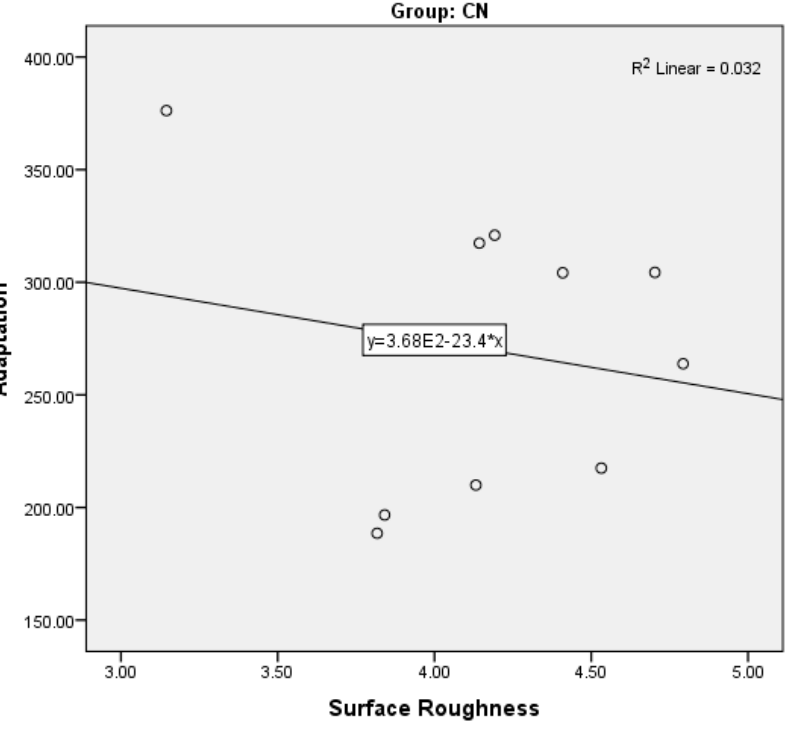
Figure 11. Scatter plot for the correlation between marginal misfit and surface roughness for the CC samples.